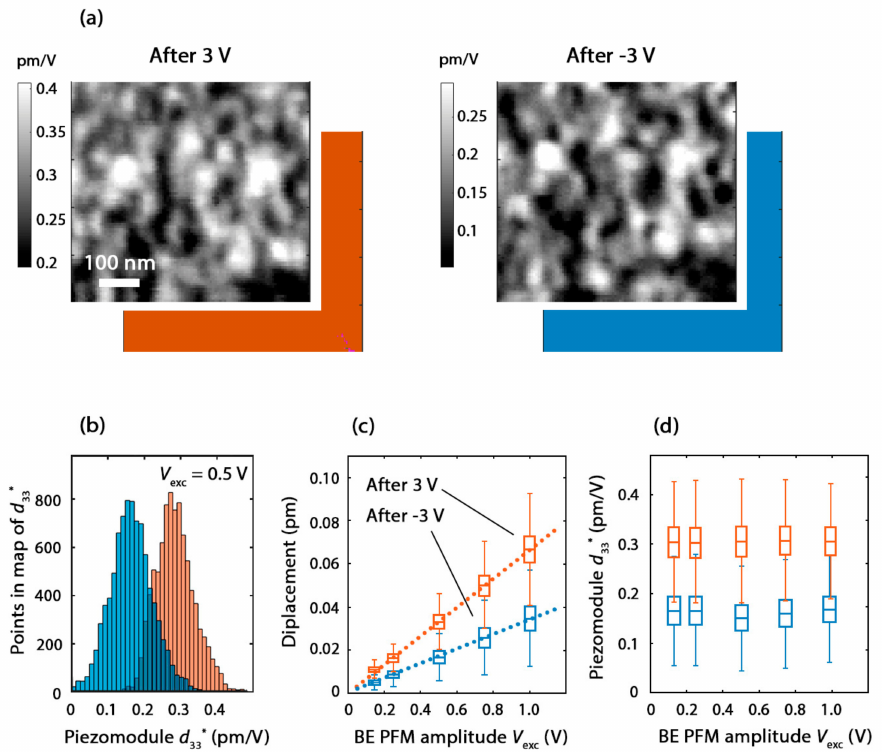
Figure 8. Distribution of the effective piezoelectric coefficient d 33 * for two polarization states. ( a ) Maps of spatial distribution of the piezoelectric coefficient and PFM phase at excitation voltage with ampli- tude V exc = 0.5 V. ( b ) Distributions of piezoelectric coefficient over regions in ( a ) at BE PFM amplitude 0.5 V. ( c ) Dependences of vertical displacement on BE PFM amplitude with box plot (statistical-type parameters of distribution of displacement over corresponding maps); ( d ) dependences of piezoelec- tric coefficient on BE PFM amplitude with box plot. In ( b – d ) orange color corresponds to upward polarization, blue color corresponds to the downward